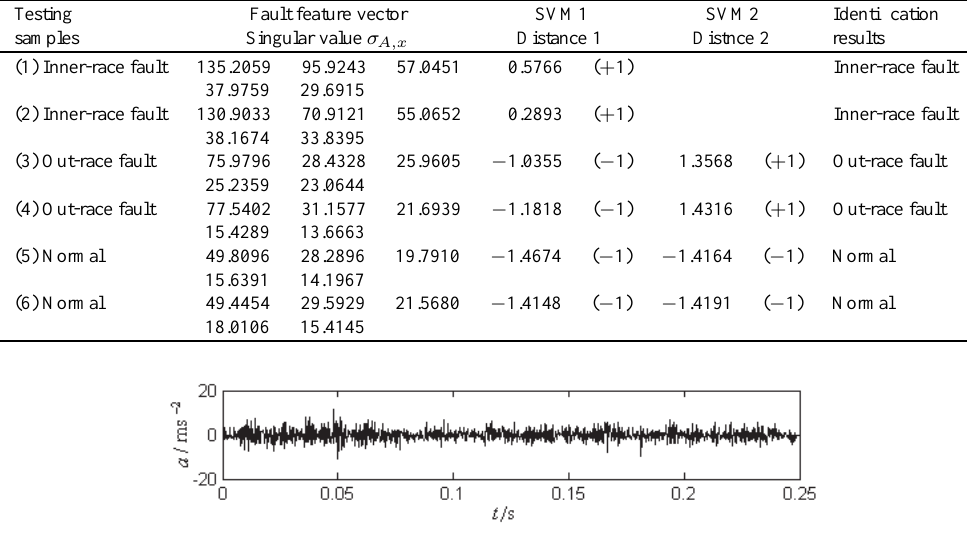
Fig. 8. The vibration acceleration signal of a roller bearing with out-race fault.